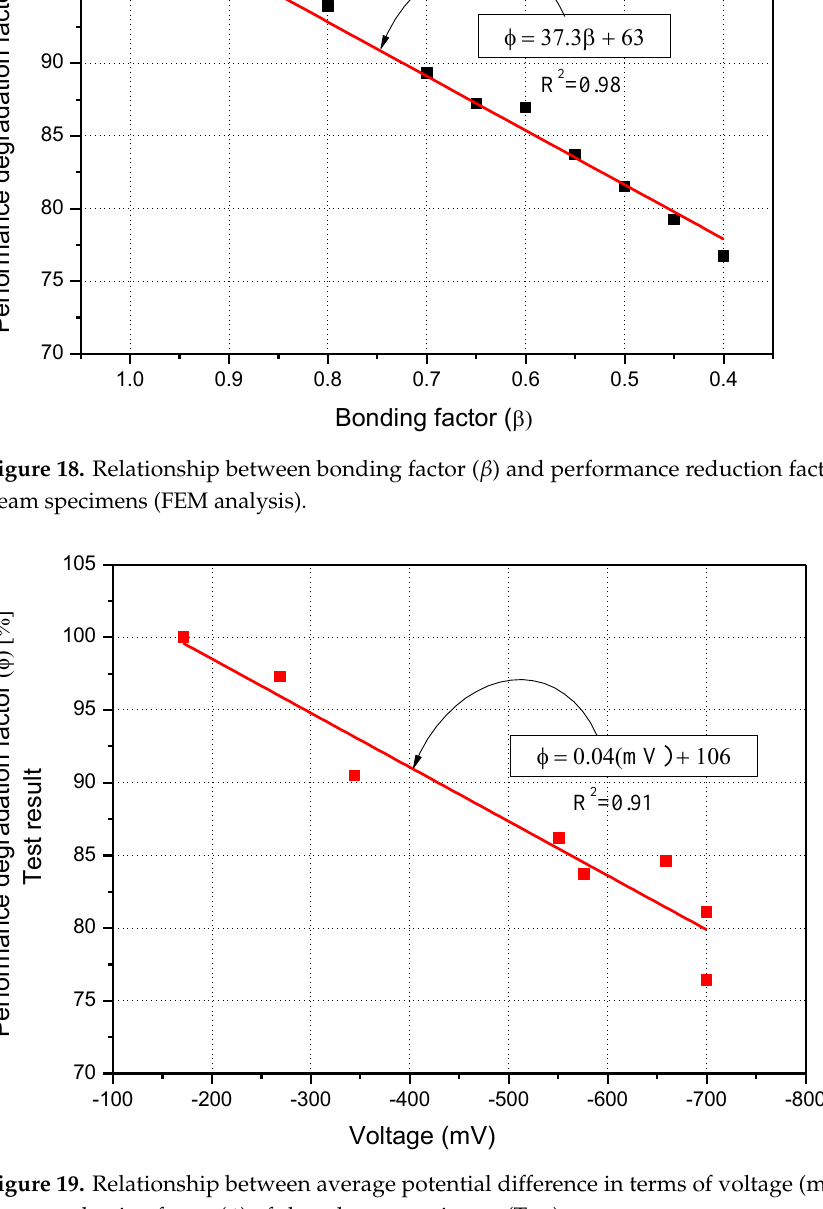
Figure 19. Relationship between average potential difference in terms of voltage (mV) and perfor- mance reduction factor ( ϕ ) of shear beam specimens (Test).